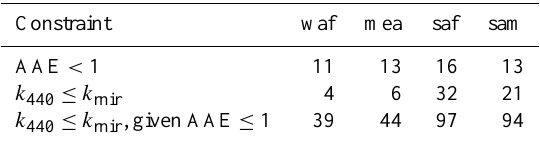
Table 2. Percentage of retrievals with AAE ≤ 1, k 440 ≤ k rnir and k 440 ≤ k rnir when AAE ≤ 1 at the West African (waf), Middle East- ern (mea), southern African (saf), and South American (sam) sites of Table